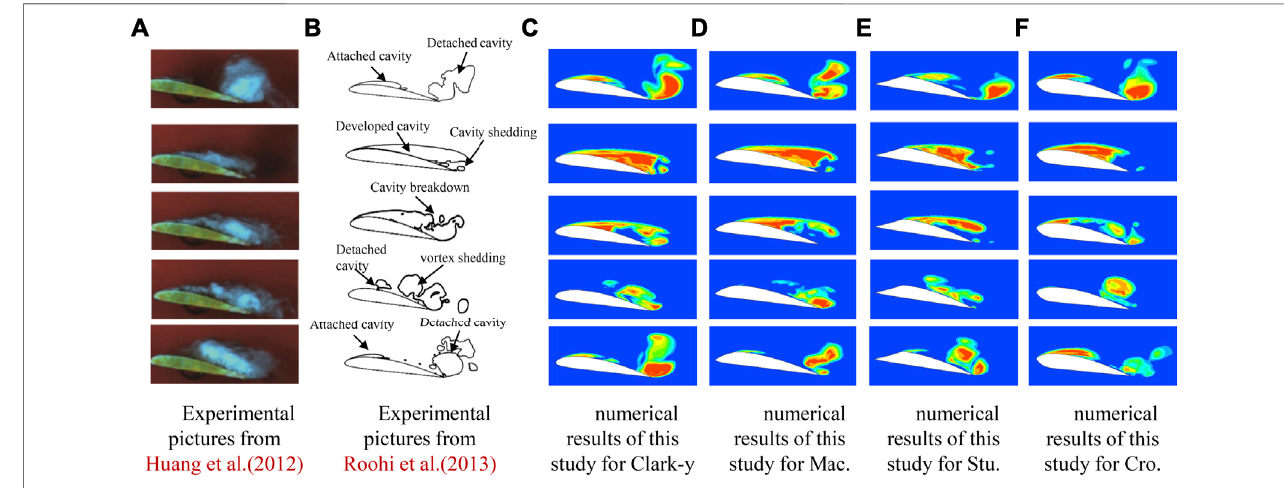
FIGURE 4 | Cavitation experimental results and numerical simulation results of different hydrofoils in a single cycle. (A) Experimental pictures from Huang et al. (2012) (B) ExperimentalpicturesfromRoohietal.(2013) (C) NumericalresultsofthisstudyforClark-y (D) NumericalresultsofthisstudyforMac. (E) Numericalresultsof this study for Stu. (F) Numerical results of this study for